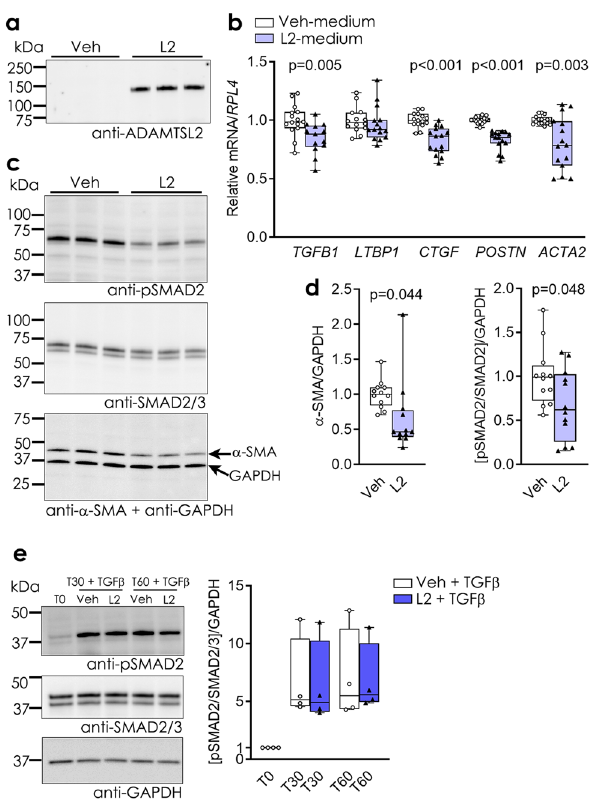
Figure 5. Extracellular ADAMTSL2 inhibits TGFβ signalling and myofibroblast differentiation in human cardiac fibroblasts. Human foetal cardiac fibroblasts (hfCFBs) treated with conditioned medium harvested from hfCFBs transduced with ADAMTSL2 (L2-medium) or vehicle control (Veh-medium, see Supplementary Fig. S3a). Data represent experiments from 3–5 different cell passages (n = 15). ( a ) Immunoblot of ADAMTSL2 in L2-medium and Veh-medium. ( b ) mRNA levels of transforming growth factor (TGF)β 1 ( TGFB1 ) , latent TGFβ binding protein 1 ( LTBP1 ), connective tissue growth factor ( CTGF ), periostin ( POSTN ), and α-smooth muscle actin (α-SMA, encoded by ACTA2 ). ( c ) Representative immunoblots of phosphorylated (pSMAD2), total SMAD2/3 and α-SMA in whole-cell protein lysates and ( d ) quantification of blots. ( e ) Representative immunoblots and quantification of pSMAD2 and total SMAD2/3 in lysates from hfCFBs treated with Veh- or L2-medium, which was pre-incubated with active, TGFβ. hfCFBs were treated for 0 (T0), 30 (T30) or 60 (T60) minutes. Uncropped blots are available in Supplementary figure IV. Gene expression was normalized to RPL4. GAPDH was used as intracellular protein loading control. Data are presented as mean ± min/max values and statistical analysis was performed using the Student t -test vs. respective